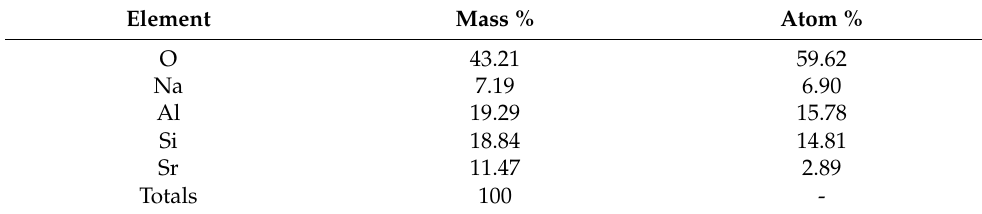
Table 1. Elemental analysis for Sr 4 Al 14 O 25 :Eu 2+ ,Dy 3+ phosphor beads. Element Mass % Atom % O